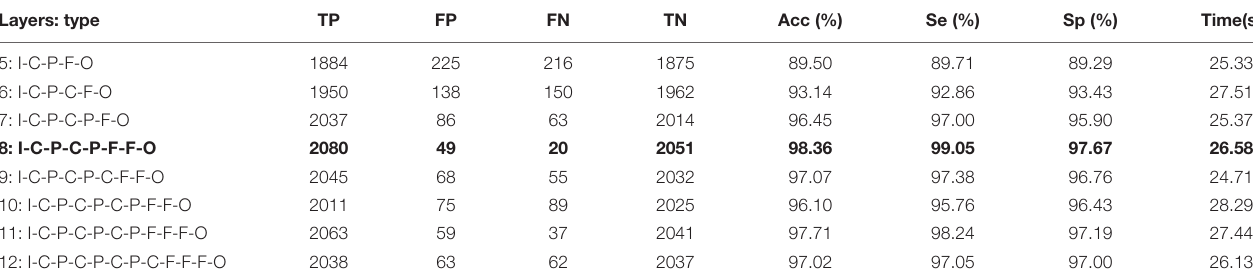
TABLE 4 | Comparison of the averaged classification performance with different layers of the convolutional neural network (CNN) model using the test dataset across 10-fold for the proposed computer-aided diagnosis (CAD) system. Layers: type